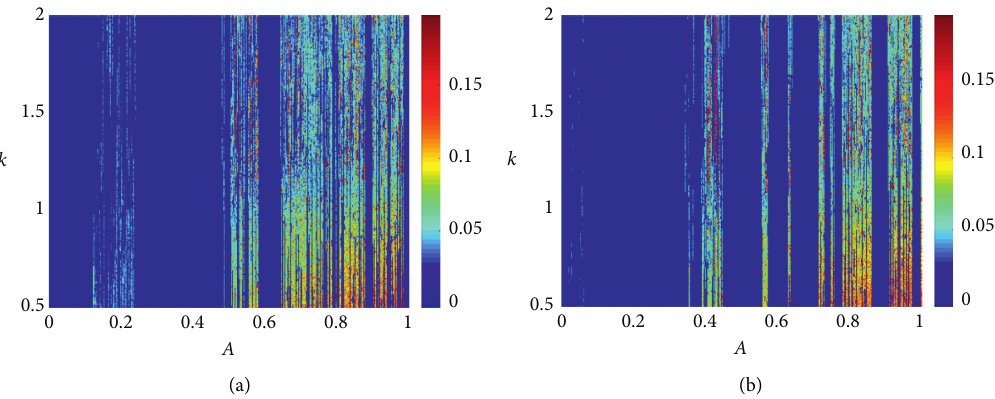
Figure 3: Coexisting of two-parameter sweep diagrams plotted in the same range of parameters with just two different initial conditions ( 30 , 0 . 2 ) and ( 1 , 0 . 2 ) . The coexisting solution regions are synthesized by the simultaneous appearance of different colors on figures for the same range of parameters. The rest of the system parameters are fixed as in the text.